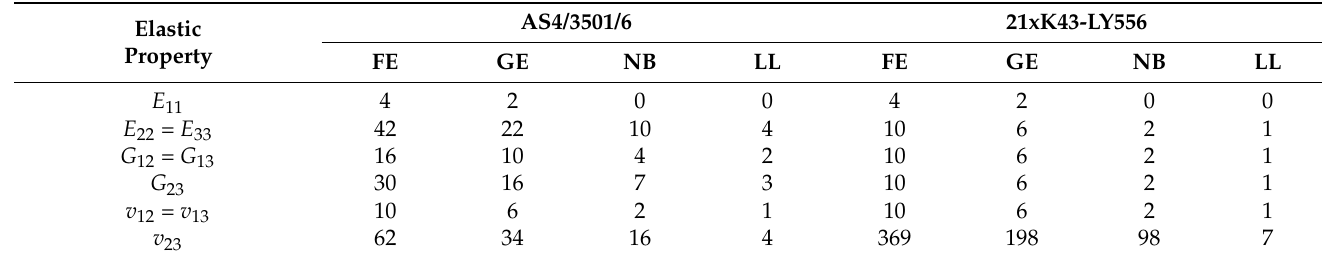
Table 7. The computational effort with large-range interval parameters (level